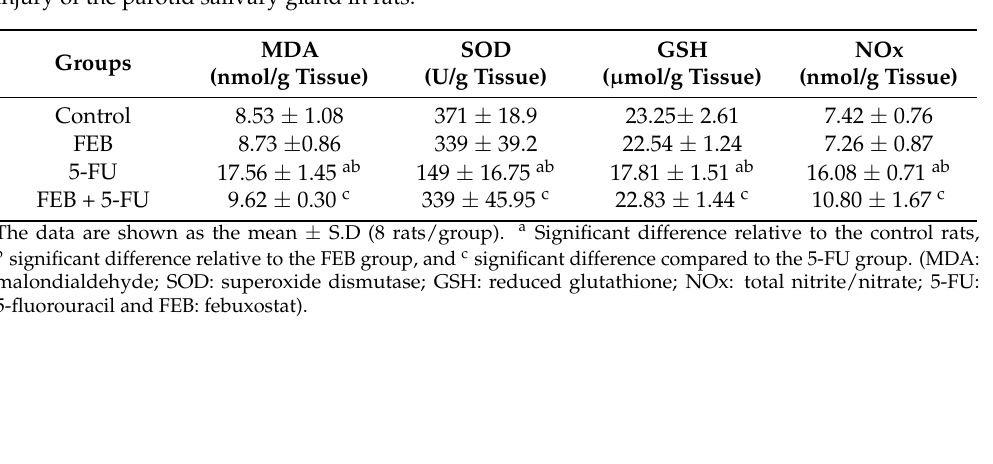
Table 2. Impact of FEB on oxidative stress parameters (MDA, SOD, GSH, and NOx) in 5-FU-induced injury of the parotid salivary gland in